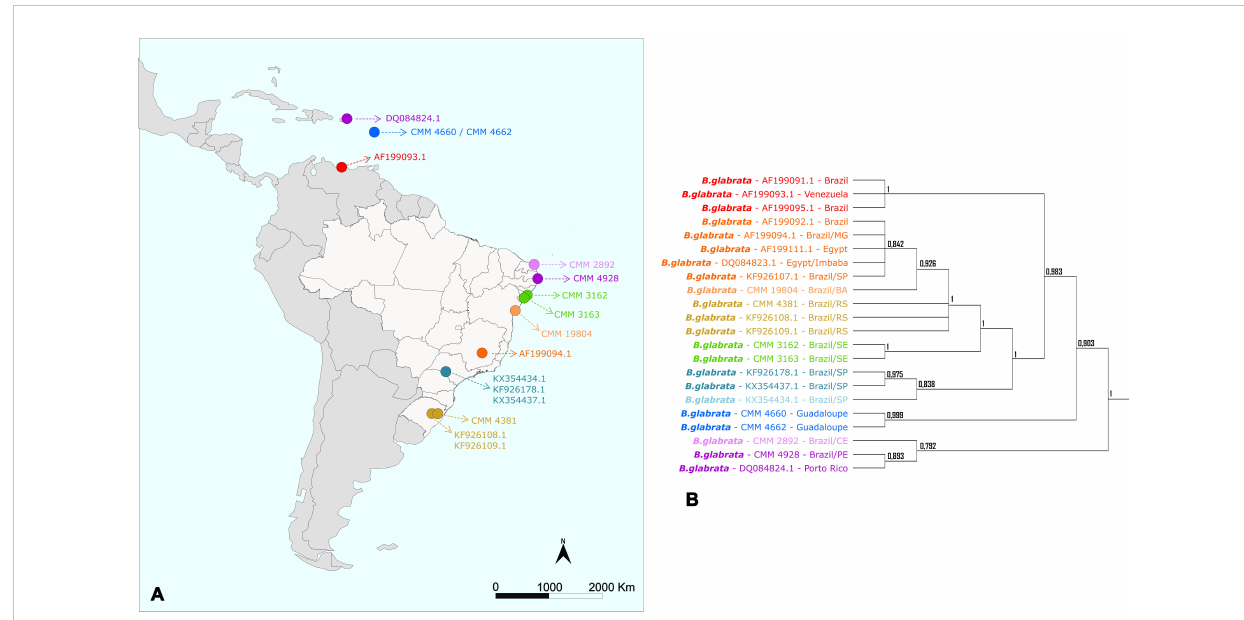
FIGURE 3 Number of sequences classi fi ed by the Best Close Match (BCM) and BOLD Identi fi cation Criteria . The bar graphs illustrate the absolute number of sequences identi fi ed using two different criteria: (A) Best Close Match (Meier et al., 2006) and (B) BOLD Identi fi cation Criteria , using the R software (version 4.0.5) and the package spider (version 1.5.0). The colors represent the four possible outcomes: correct (green), incorrect (red), ambiguous (yellow), and no identi fi cation (blue).